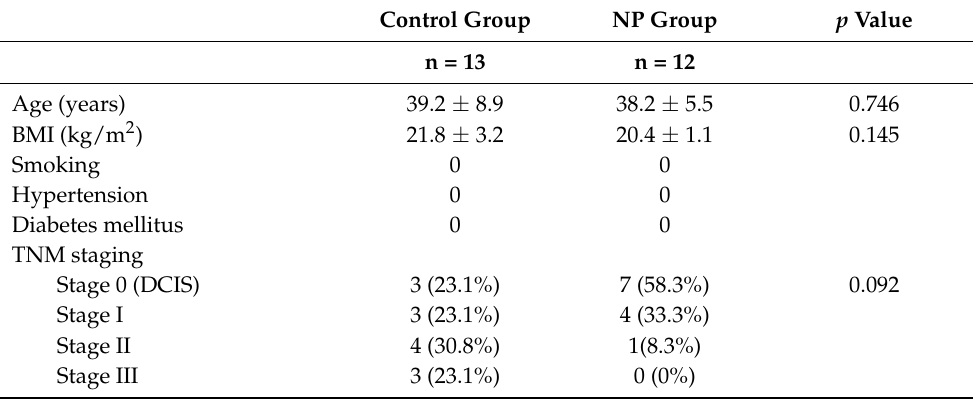
Table 3. Clinical characteristics and demographics of two groups of